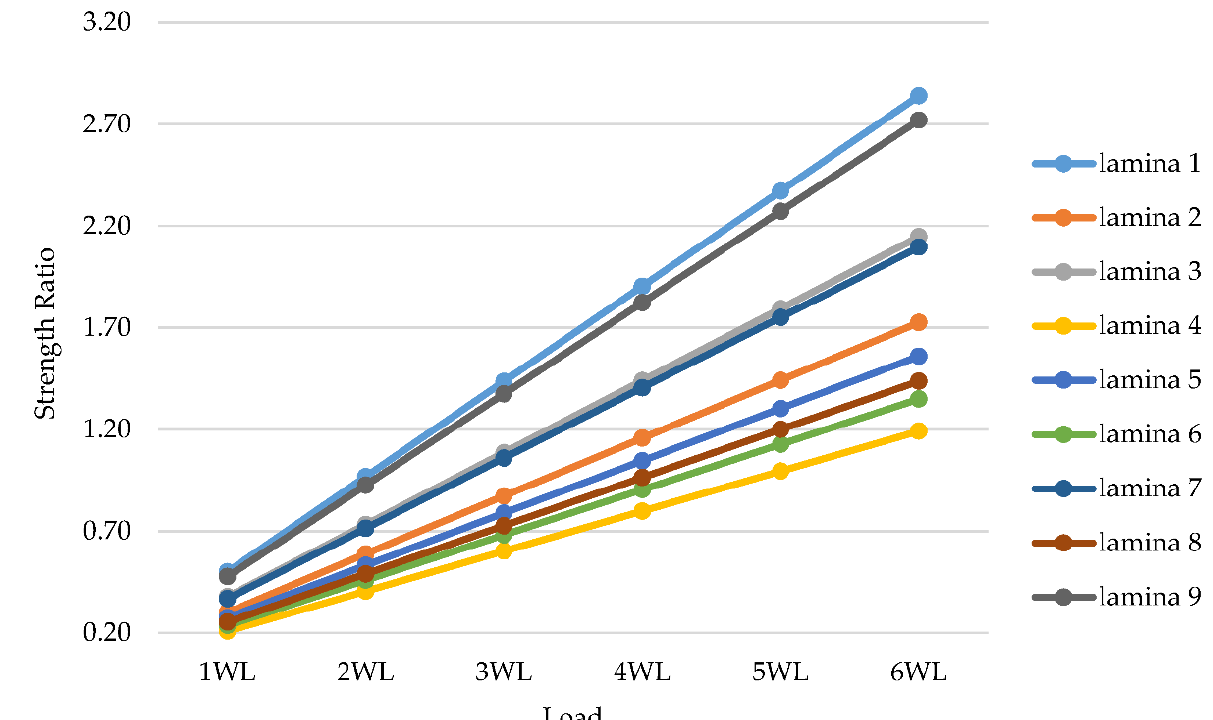
Figure 12. Strength ratio with different loads for GFRP composite cross ‐ arm.